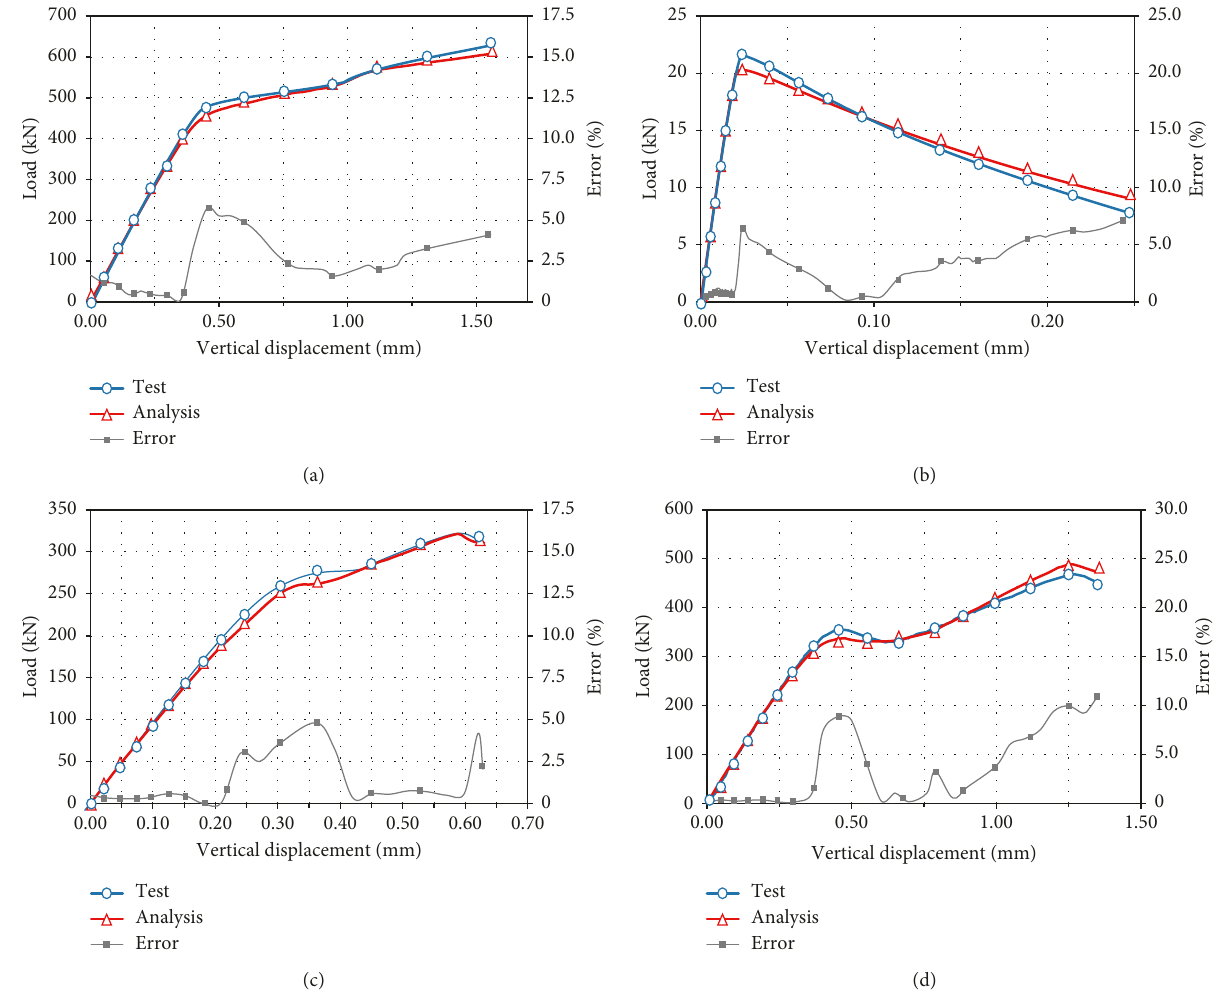
Figure 16: Comparison between analytical and experimental results: (a) MN-0; (b) VC-0; (c) GR-20; (d)